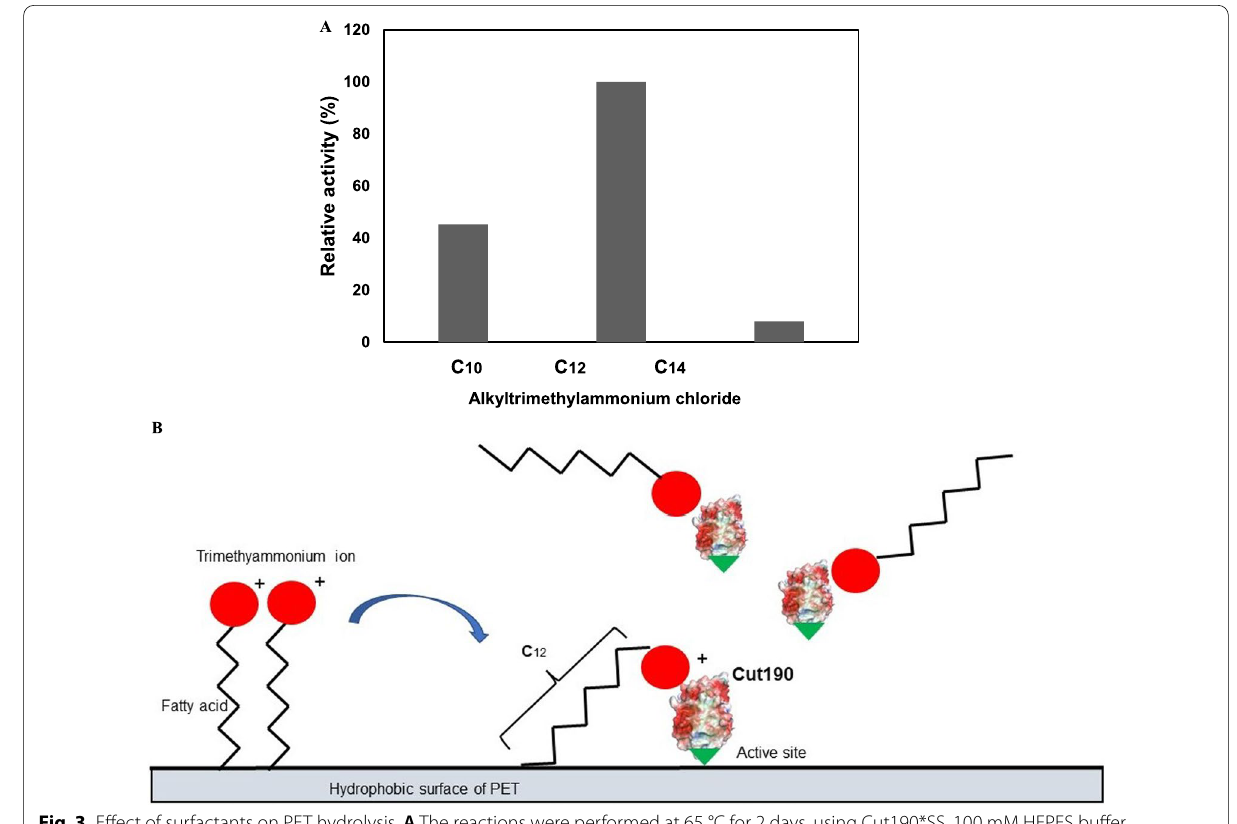
Fig. 3 Effect of surfactants on PET hydrolysis. A The reactions were performed at 65 °C for 2 days, using Cut190*SS, 100 mM HEPES buffer (pH 8.5), 30 ppm (90 μM) surfactant and one piece of 6 mm PET-GF film, as described in “Materials and methods”. Surfactants used were ∅ decyltrimethylammonium chloride (C